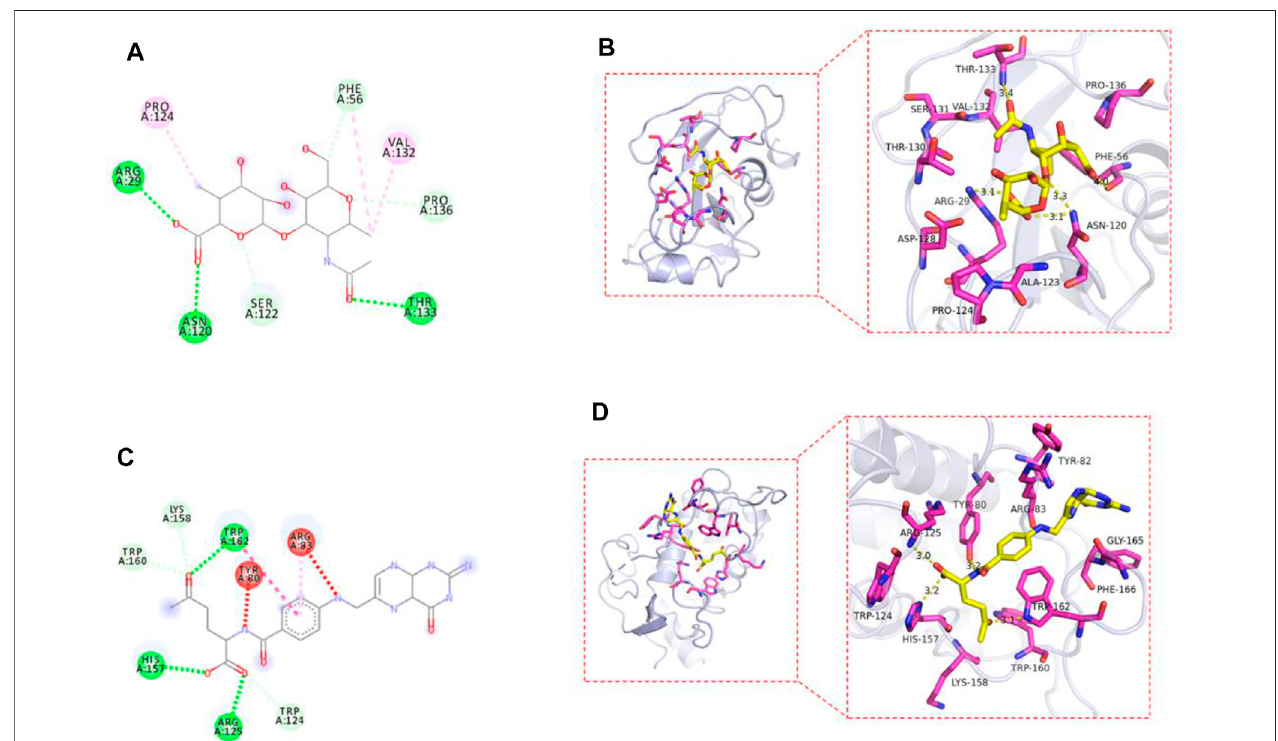
FIGURE 7 | 2D plan view of the docking interaction between drug-loaded micelles and CD44 (A) ; FOLR1 (C) . 3D plan view of the docking interaction between drug-loaded micelles and CD44 (B) ; FOLR1 (D) .